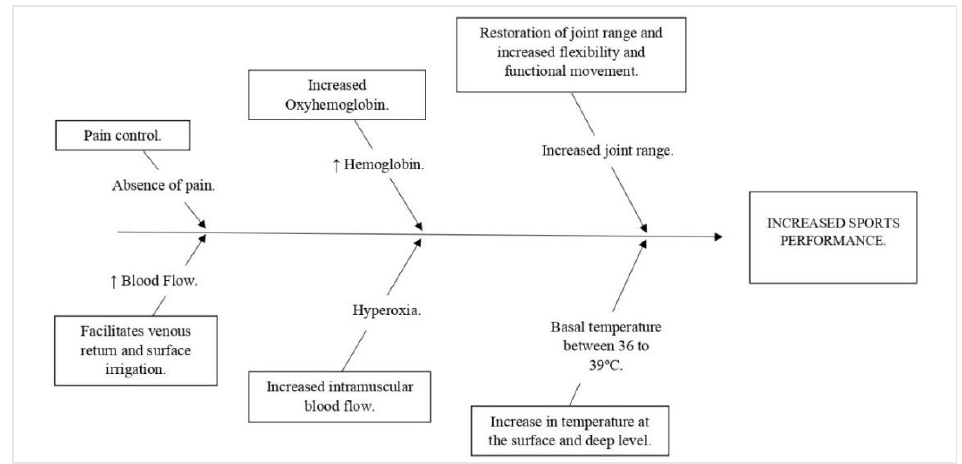
Figure 1. Cause-effect diagram (Ishikawa ’ s Thorn) of the theoretical effect of the application of CRET on sports performance, and the relationship between the effects of radiofrequency and factors that modify sports performance according to the literature. Source: Own elaboration.